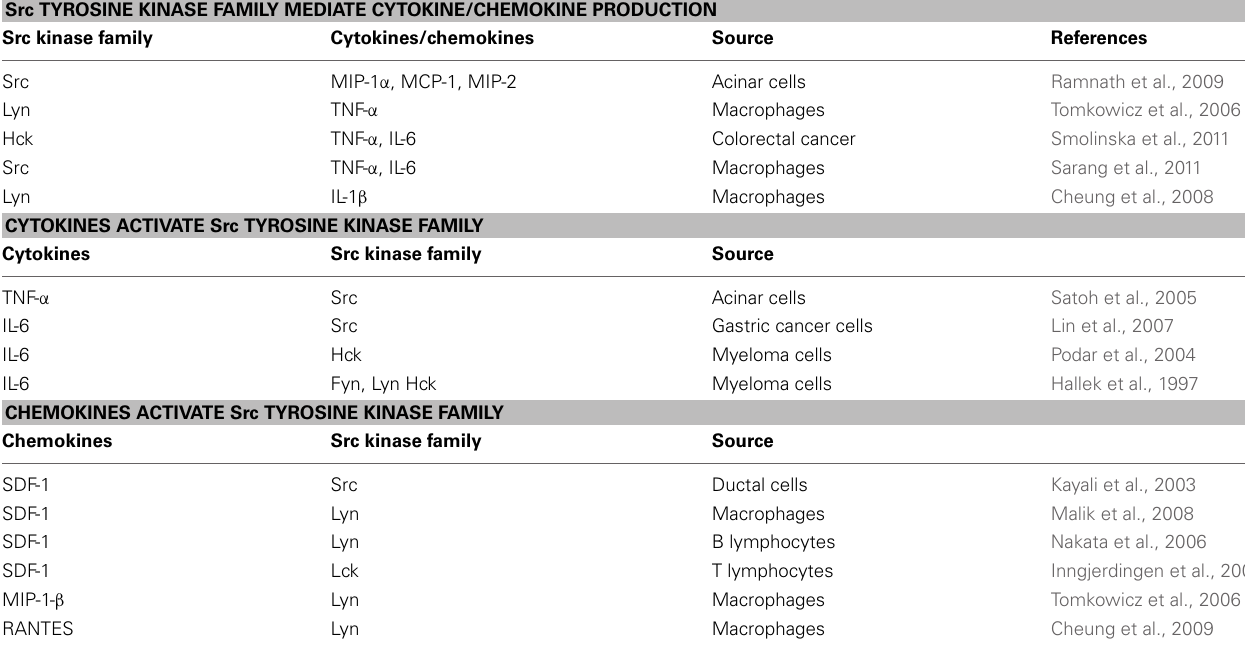
FIGURE 1 | Src-dependent cross talk between inflammatory and cancer cells. Src activation is driven in both inflammatory cells and cancer cells by pro-inflammatory cytokines within the tumor microenvironment. Activation of Src kinases in immune cells by tumor-secreted cytokines (chemokines: SDF-1, MIP-1, MCP-1, MIP-2, etc.) induces production of cytokines (TNF-a, Table 1 | Src tyrosine kinase family and cytokine/chemokine interaction in immune and cancer